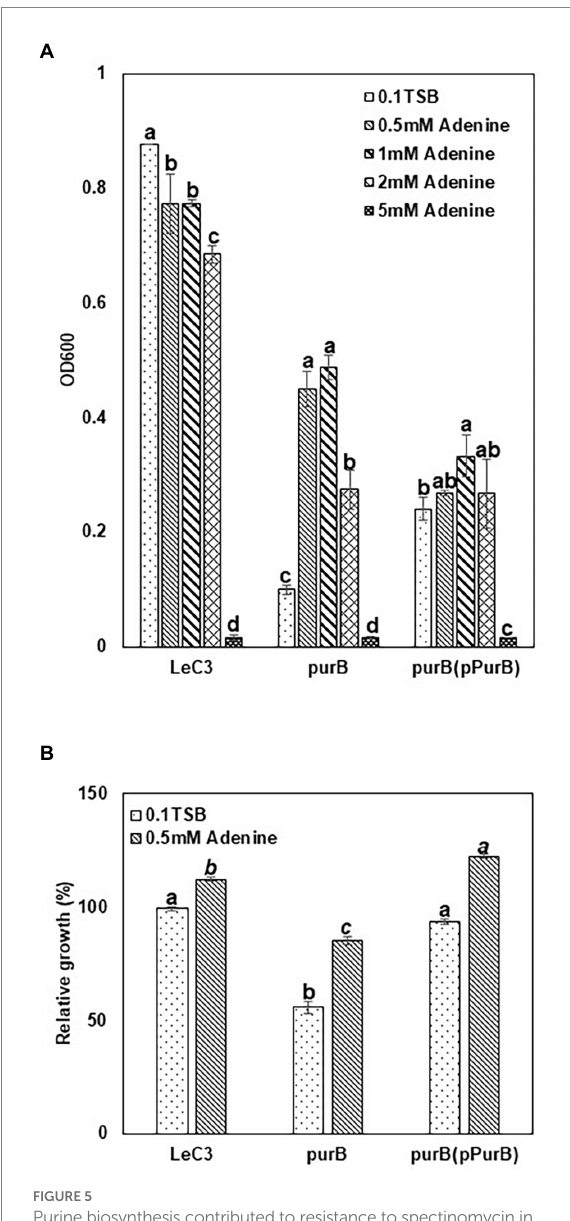
FIGURE 5 Purine biosynthesis contributed to resistance to spectinomycin in LeC3. (A) Growth of LeC3 and its derived strains on different adenine concentration at 24 hpi. The absorbance at 600 nm was measured to represent bacterial growth. Within each strain, different letters indicated significant differences among different concentrations of adenine from one-way ANOVA followed by Fisher’s LSD test ( p < 0.05). In addition, “ab” means significant difference with “c,” but not with “a” or “b.” (B) Spectinomycin resistance of LeC3 and its derived strains with and without adenine at 24 hpi. Spectinomycin resistance was calculated as the ratio of bacterial growth with 500 μ g/ml spectinomycin to bacterial growth without spectinomycin. Within each concentration of adenine, different letters indicated significant differences among different bacterial strains from one-way ANOVA followed by Fisher’s LSD test ( p < 0.05). Error bars represented SD. LeC3, Lysobacter enzymogenes strain C3; purB , the purB mutant.